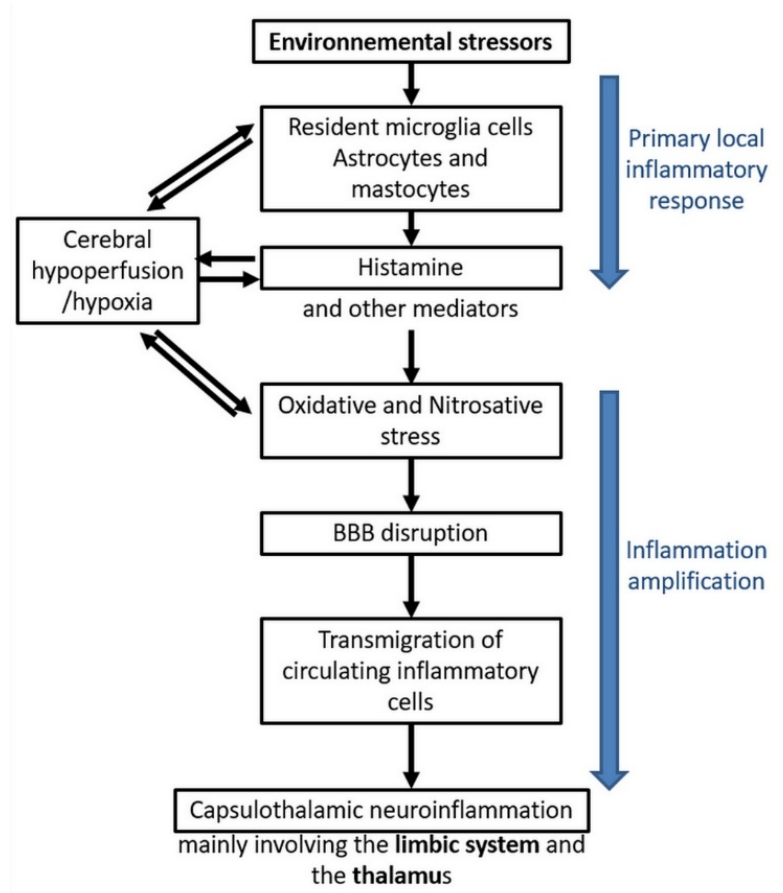
Figure 6. EHS/MCS physiopathological model based on low-grade neuroinflammation and oxidative / nitrosative stress-induced blood–brain barrier disruption, according to Reference [10].